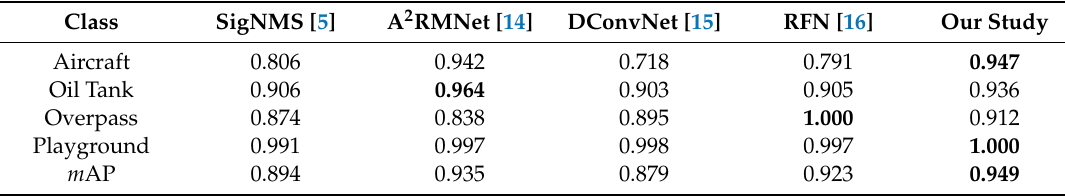
Table 4. Success of diverse models on the RSOD